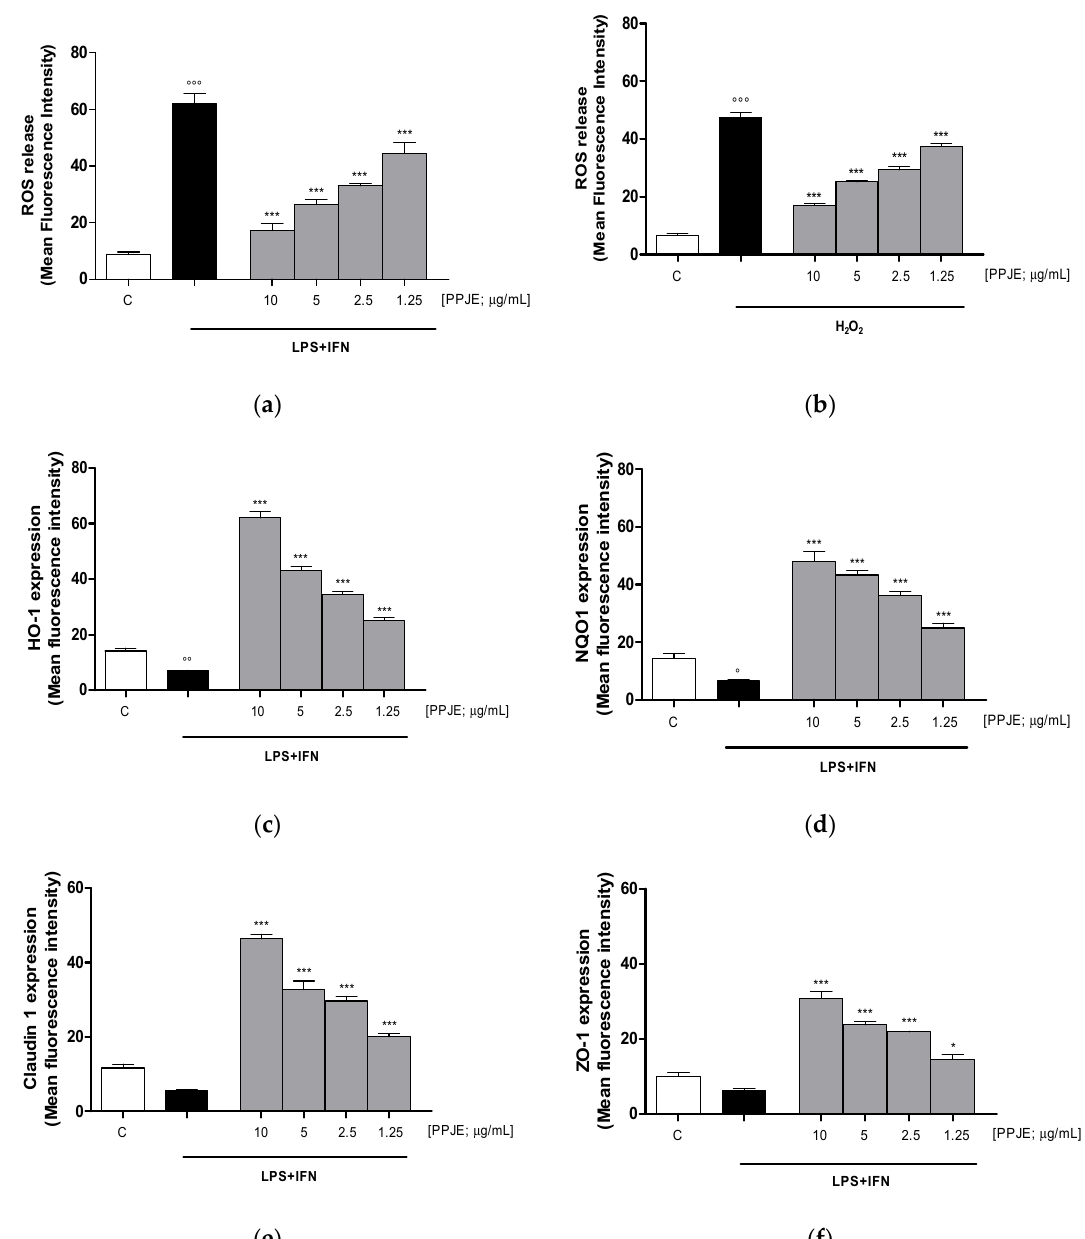
Figure 3. Effect of PPJE (10–1.25 μ g/mL) on the inhibition of intracellular ROS release in LPS + IFN ( a ) and in H 2 O 2 ( b )–stimulated IEC-6, detected by 2 ′ ,7 ′ dichlorofluorescein-diacetate (H 2 DCF-DA). Effect of PPJE (10–1.25 μ g/mL) in increasing the antioxidant proteins HO-1 ( c ) and NQO1 ( d ). In the lower panels the effect of PPJE on the expression of the tight junction (TJ) proteins Claudin-1 ( e ) and ZO-1 ( f ), detected by flow cytometry, was reported. Data are expressed as mean fluorescence intensity. C denotes control group. *** and * denote respectively p < 0.001 and p < 0.05 vs . LPS + IFN or H 2 O 2 ; °°°, °° and ° denote respectively p < 0.001, p < 0.01 and p < 0.05 vs . C.